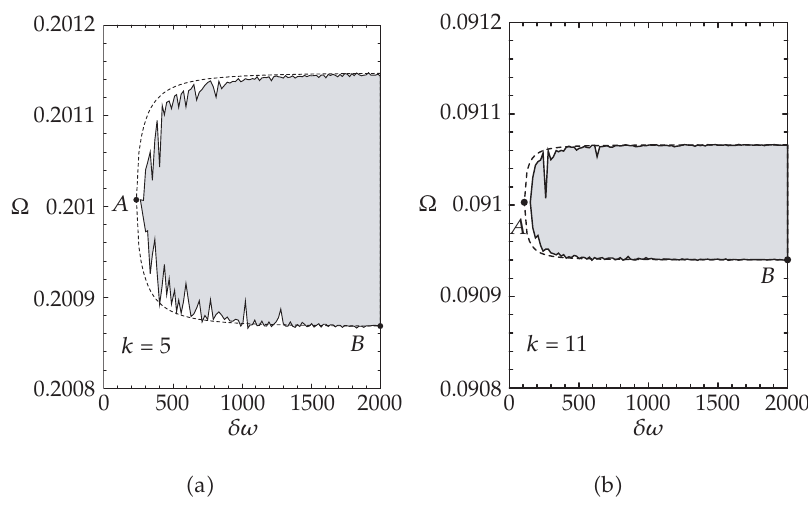
Figure 7.1 . The probability of generation of unwanted states P at di ff erent values of δω and Ω . In the gray regions P < P 0 , P 0 = 10 − 5 . The region delimited by the dashed line is obtained using ( 5.8 ) . The gray region delimited by the solid line is obtained using the im- proved perturbation theory described in Section 6. The position of the point A in Ω satisfies the 2 πk condition ( 3.19 ) , Ω = Ω k , where the values of k are indicated in the figures. L =